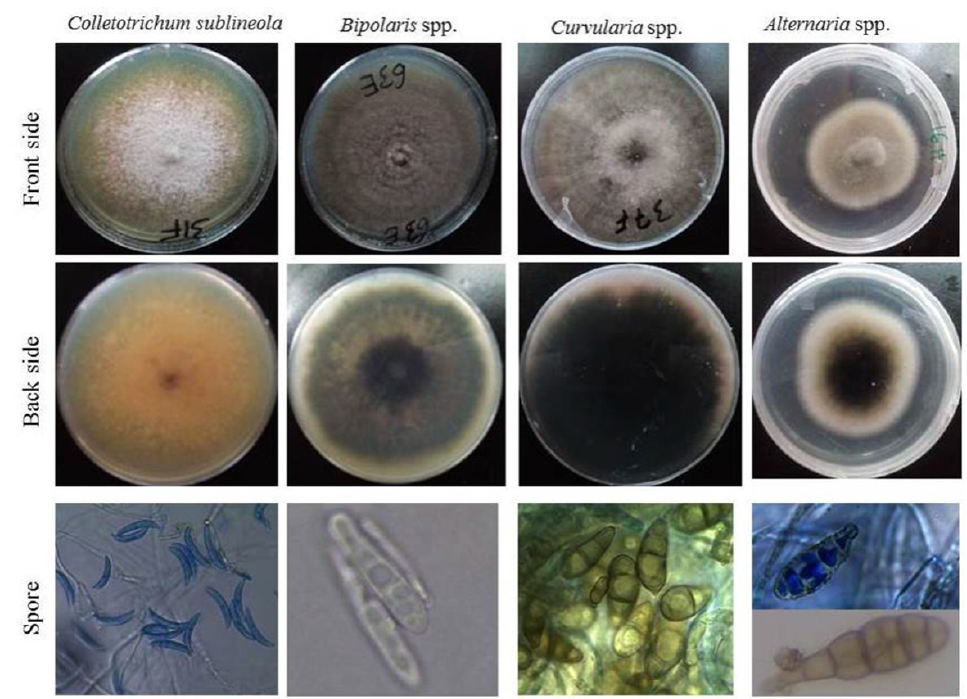
Figure 7. Representative colonies formed on PDA and conidial morphological characteristicsof the various sorghum fungal